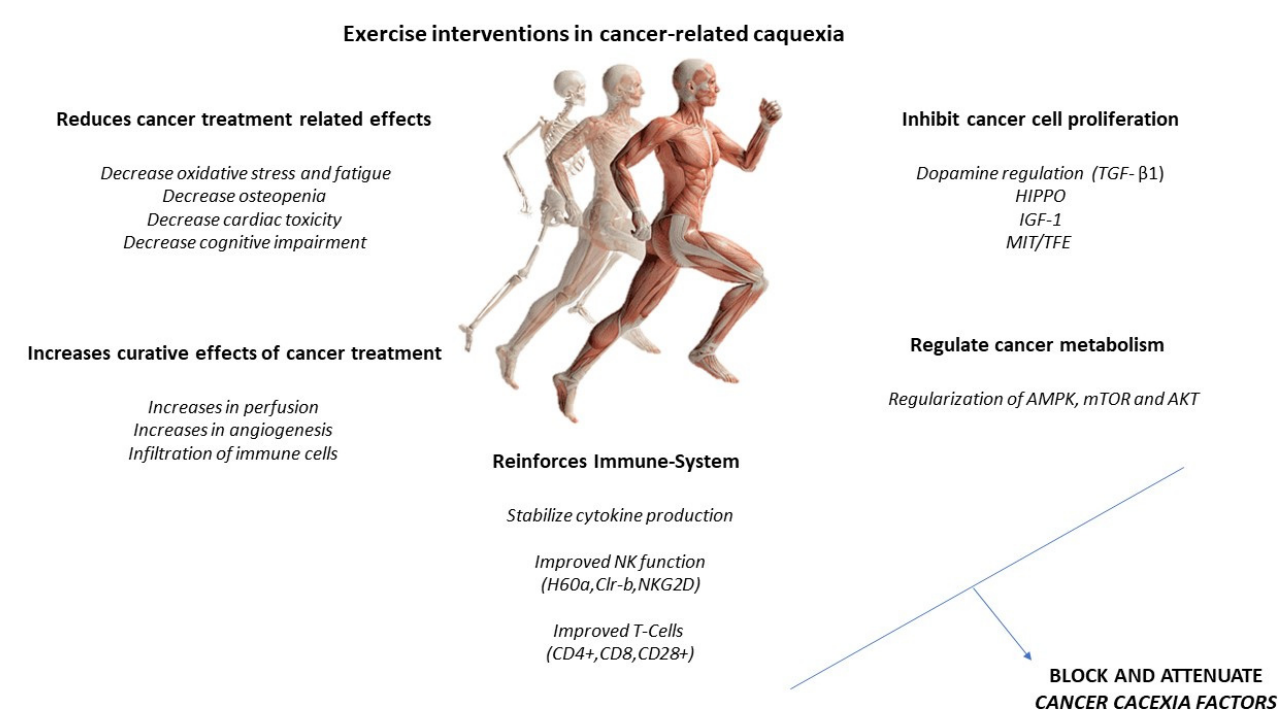
Figure 3. Exercise intervention in cancer-related cachexia.